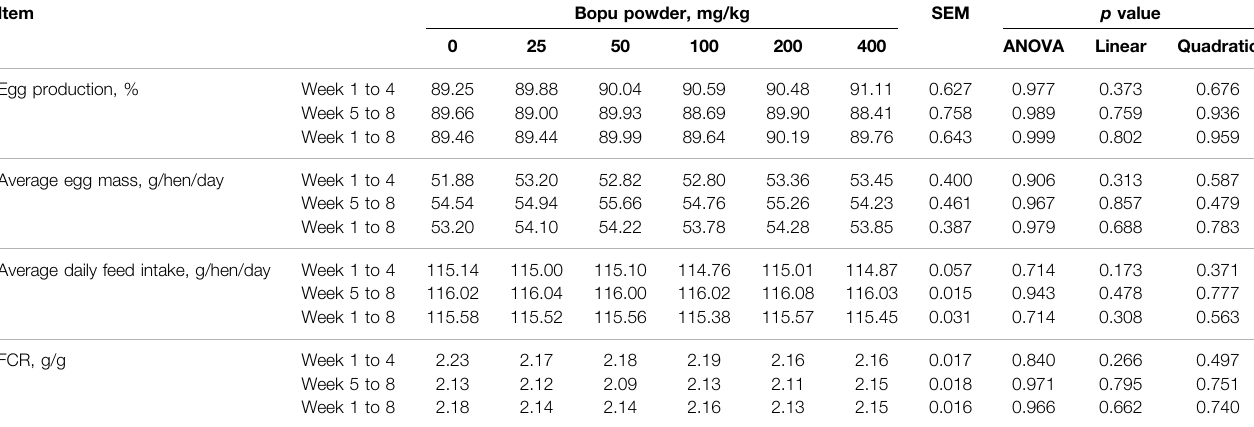
TABLE 2 | Effect of dietary Bopu powder supplementation on the performance of laying hen.